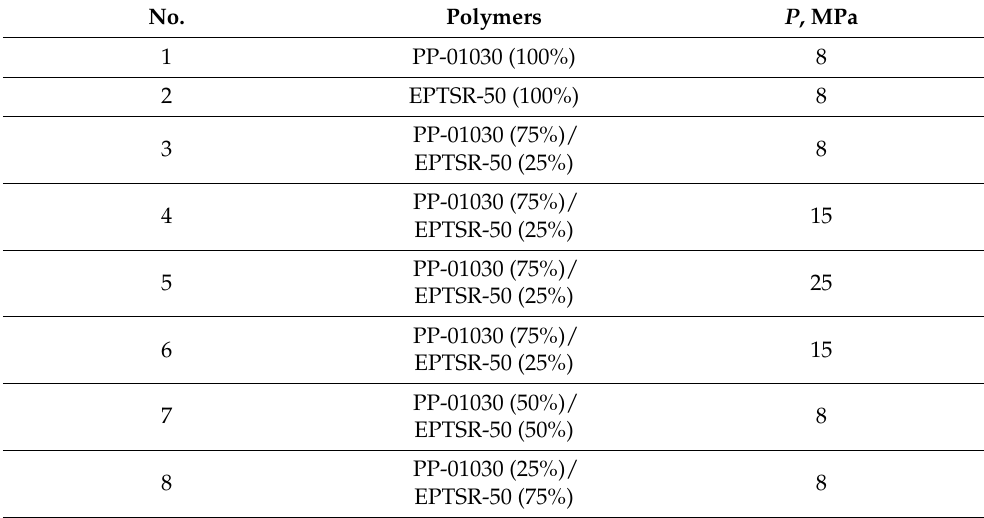
Table 3. Operating pressures for the process of dispersing polymer mixtures by the SEDS method at temperature of t = 40 ◦ C (polymer’s mixture concentration in the solvent is 4 wt%, nozzle diameter is 200 µ